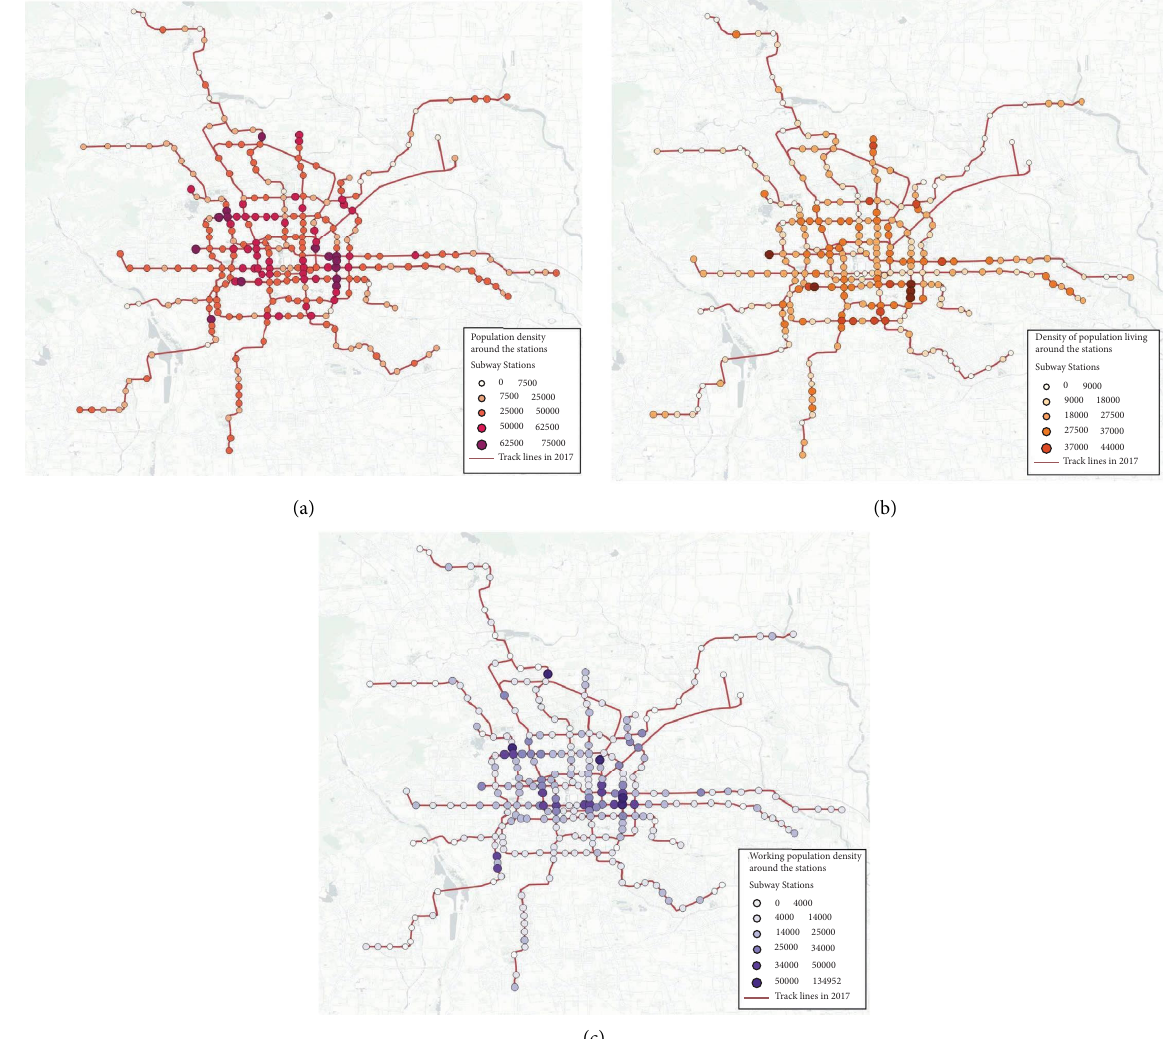
Figure 13: Population characteristics around the stations. (a) Population density around the stations; (b) density of population living around the stations; (c) working population density around the